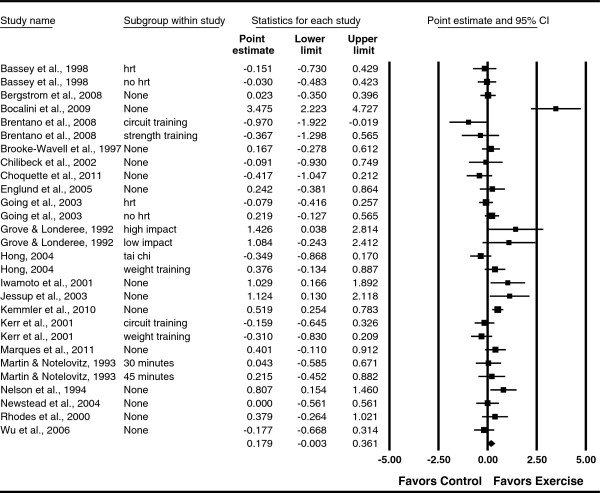
Forest plot for changes in LS BMD. Forest plot for point estimate standardized effect size changes (g) in LS BMD. The black squares represent the standardized mean difference (g) while the left and right extremes of the squares represent the corresponding 95% confidence intervals. The middle of the black diamond represents the overall standardized mean difference (g) while the left and right extremes of the diamond represent the corresponding 95% confidence intervals. For subgroup, HRT means hormone replacement therapy.